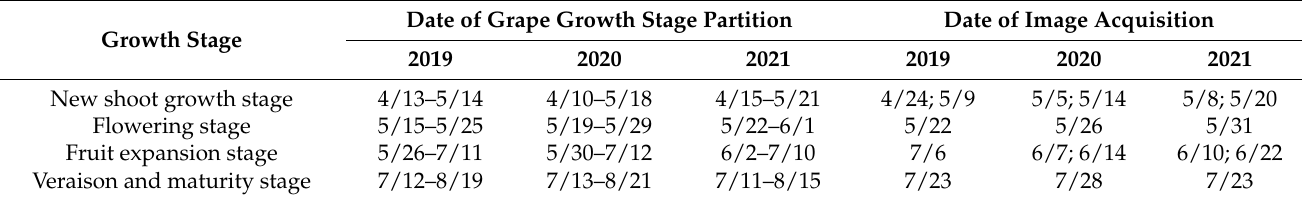
Table 1. Date of grape growth stage partition and image acquisition during